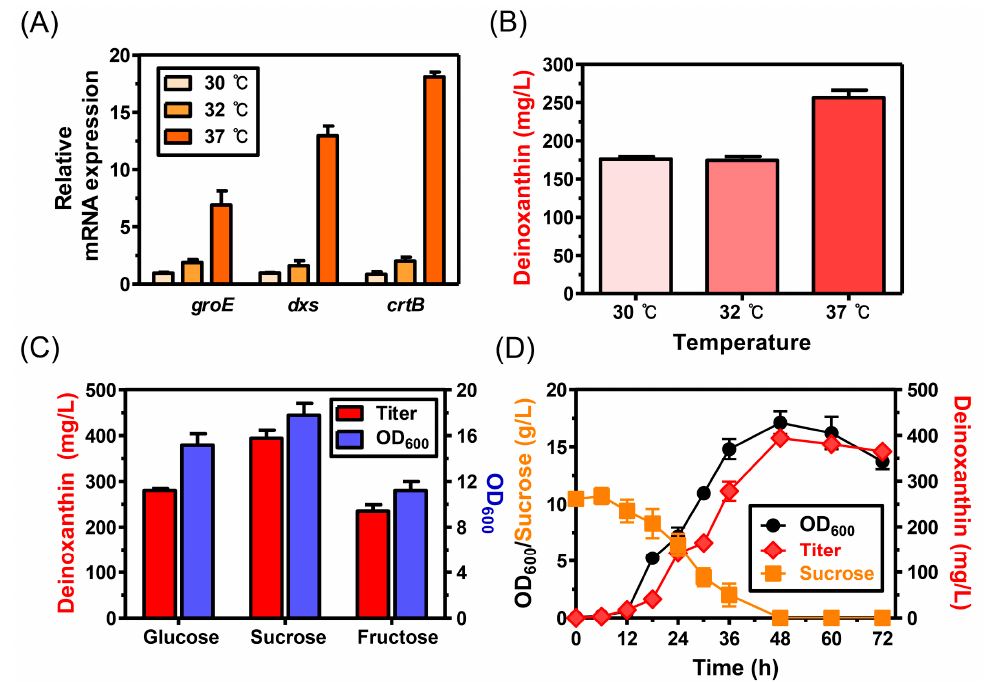
Figure 2. Deinoxanthin production by the D. radiodurans strain DX2 under different culture conditions. ( A ) Transcription profiles of the genes groE , dxs , and crtB based on the growth temperature. The strain DX2 cultured at 30 °C was used as a control to normalize gene expression. Each sample was taken at 36 h for qRT-PCR analysis. ( B ) Deinoxanthin production under different growth temperatures. ( C ) Deinoxanthin production using different carbon sources (10 g/L). ( D ) Shake flask batch culture in TY medium containing 10 g/L sucrose under 72 h of incubation. All experiments were performed in triplicate, and the error bars represent the standard deviation.